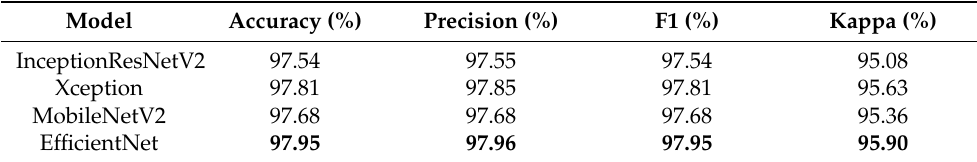
Table 2. Comparison of different CNN networks for Task 1.